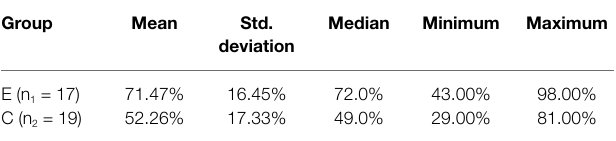
TABLE 2 | Descriptive statistics of the experimental (E) and control (C) groups in the post-test. Group